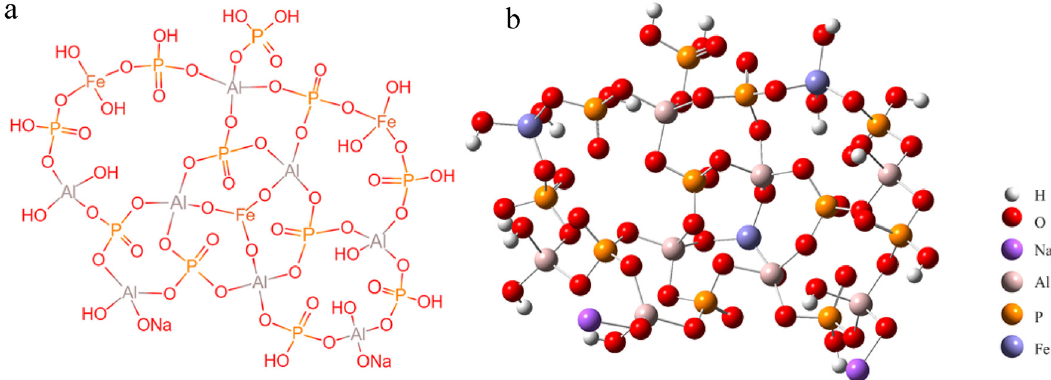
Figure 10: Structural formula ( a ) and ball and stick model ( b ) of sodium iron aluminum